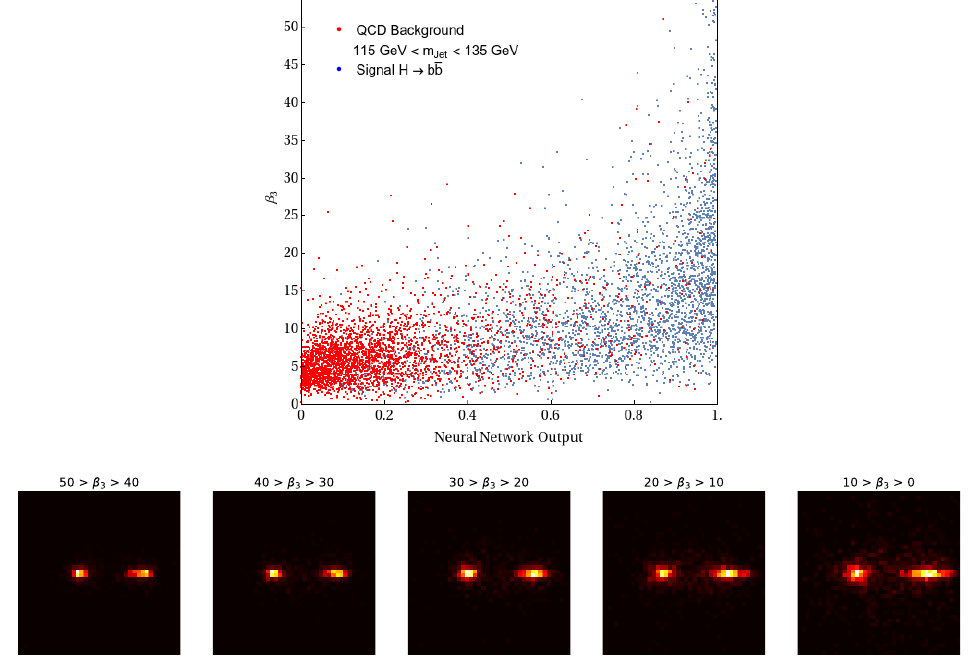
Figure 7 . Top: the joint distribution of (cid:12) 3 and the neural network. Bottom: the average of many signal images in decreasing (cid:12) 3